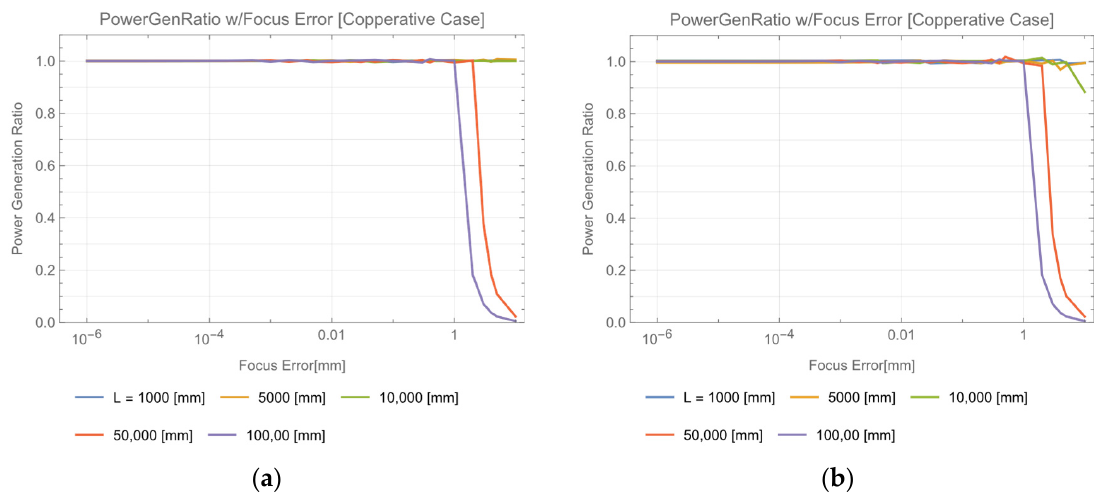
Figure 9. Power Generation Ratio Dependence on Focus Adjustment: ( a ) Focus Optimized at Each L; ( b ) Focus Optimized at 100 m.